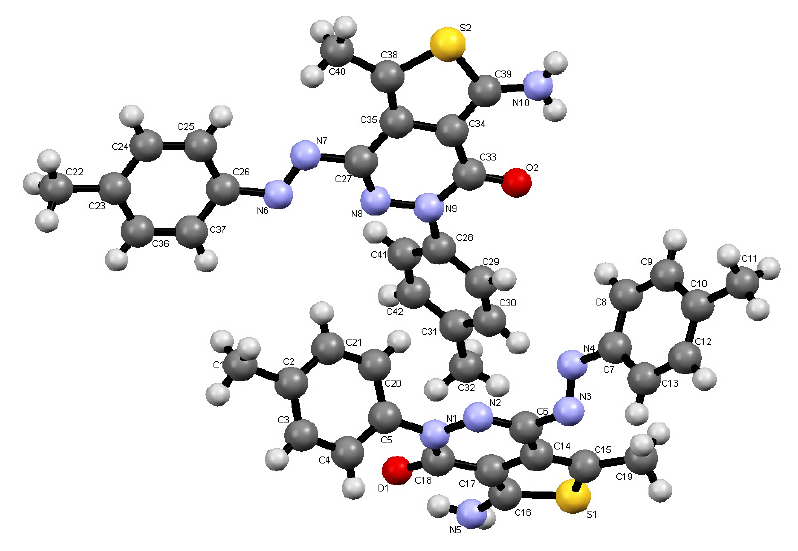
Figure 1. ORTEP plot of the X-ray crystallographic structure of 4 .